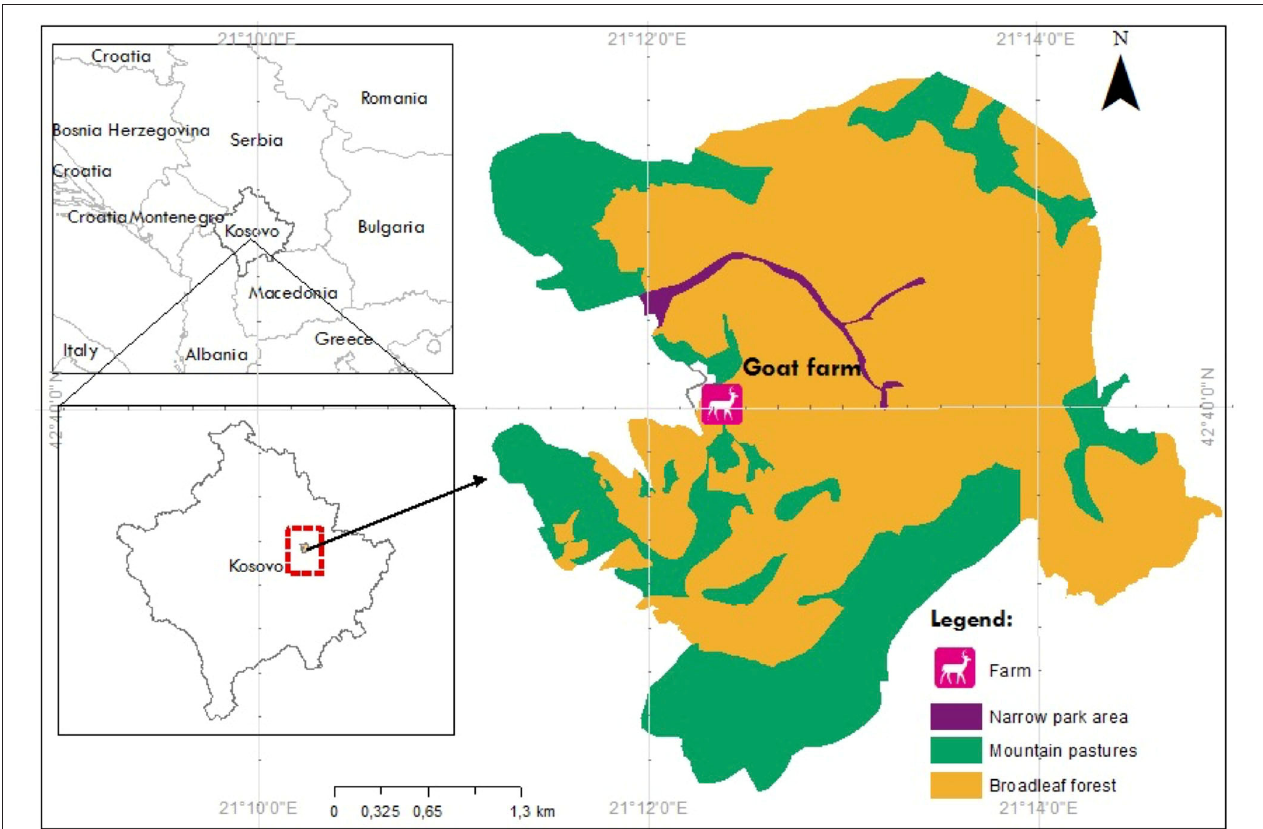
FIGURE 1 | The geographical location of goat farm included in the